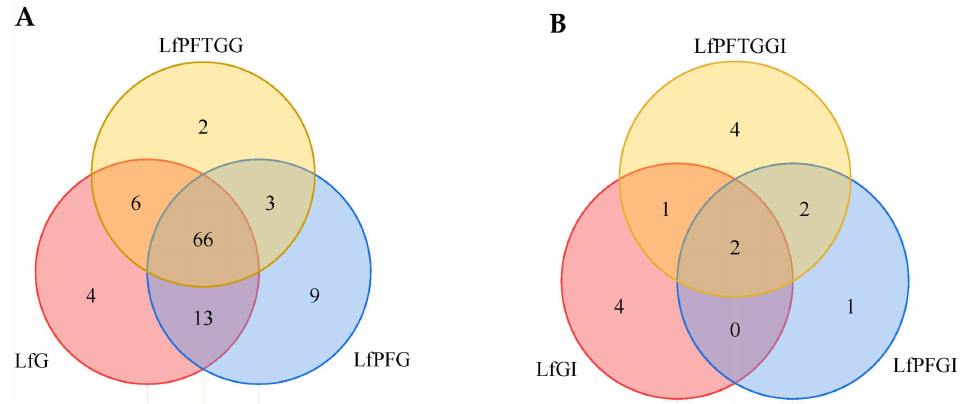
Figure 4. Venn’s plots for differential peptide numbers detectable in the digests of bLf, LfPF complex, and LfPFTG complex after in vitro gastric digestion ( A ) and gastrointestinal digestion ( B ).